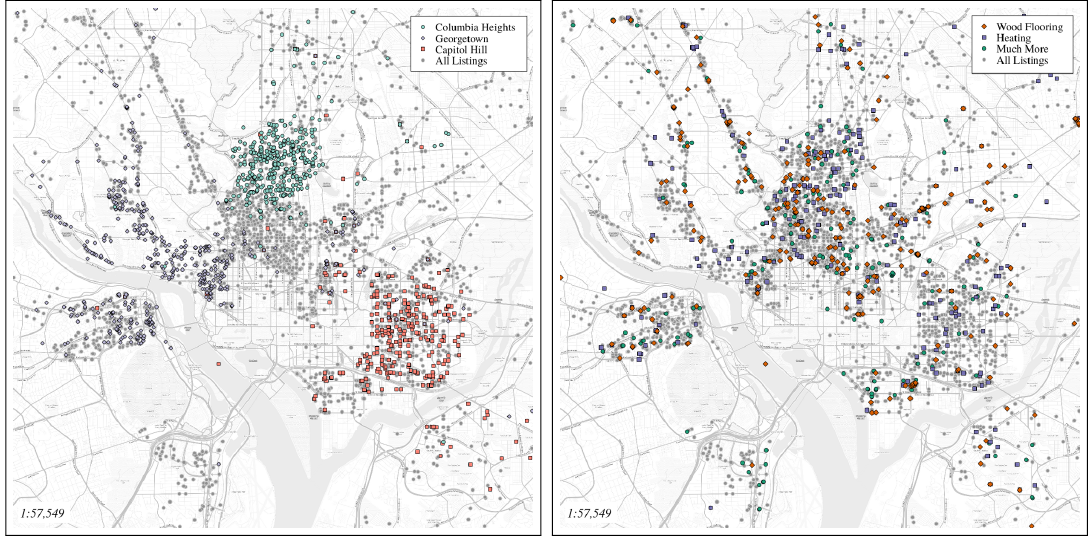
Figure 1. n-grams mapped from rental property listings in Washington, DC. ( a ) shows the clustering Figure 2. N-grams mapped from rental property listings in Washington DC. (a) shows the clustering behavior of three neighborhood names, while ( b ) visually depicts the lack of clustering for a sample of behavior of three neighborhood names while (b) visually depicts the lack of clustering for a sample of generic housing generic housing terms.